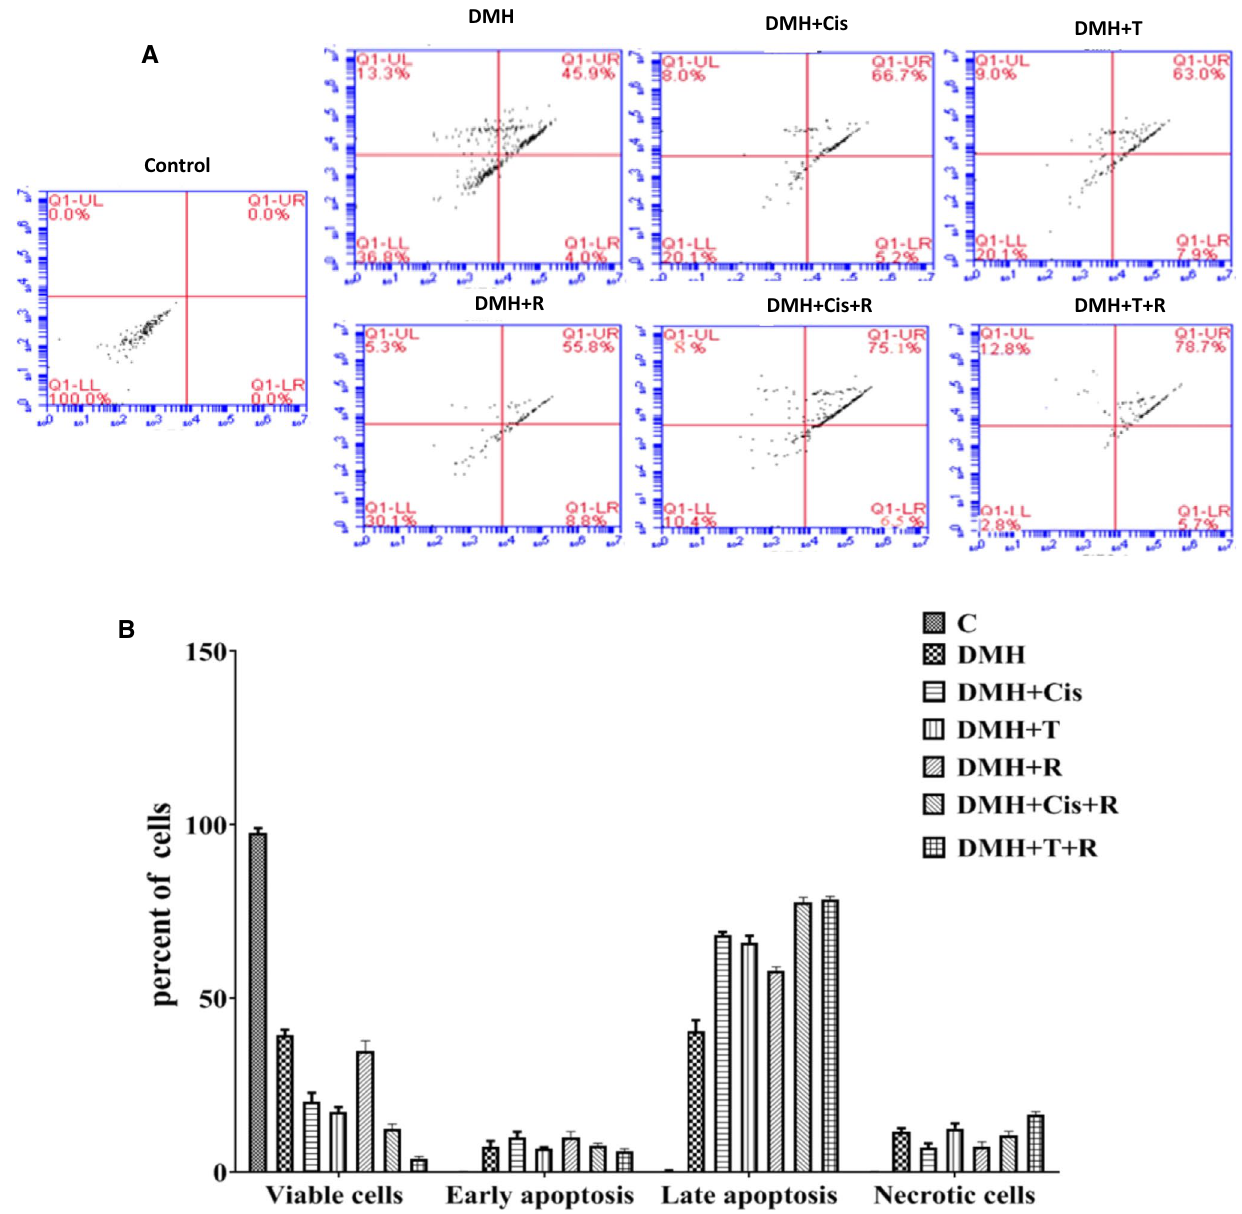
Fig. 9 Apoptosis detected by flow cytometry with Annexin V-FITC conjugated with PI staining. A. a representative from each group, B. the means of three samples from each group. C: control, DMH: dimethyl hydrazine, Cis: cisplatin, T: thiophene derivative, R: radiation. Values are the mean ± SEM (n = 3). a Significant change compared to the control group. b Significant change compared to DMH group. C Significant change compared to DMH + Cis. d Significant change compared to DMH + T. The upper right and upper left quadrants represent the late apoptotic and necrotic cells, respectively. The lower left and lower right quadrants represent the viable and early apoptotic cells, respec- tively in percent of the total gated